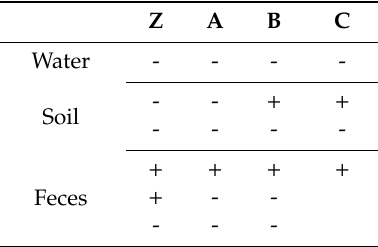
Table 5. Summary of DNA amplification results from environmental samples collected along four transects (A–C, Z) in St. Paul Woods. DNA amplified using primer CYCLO18S, “-“ indicates